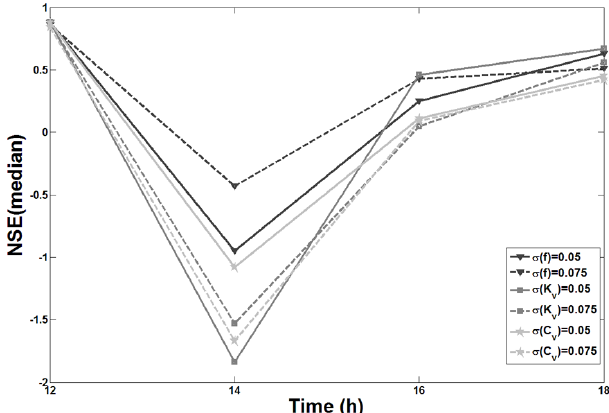
Fig. 4. Comparison of forecast model results by the NSE ( ˜ y 0 ) for different dispersion in the mutation process.